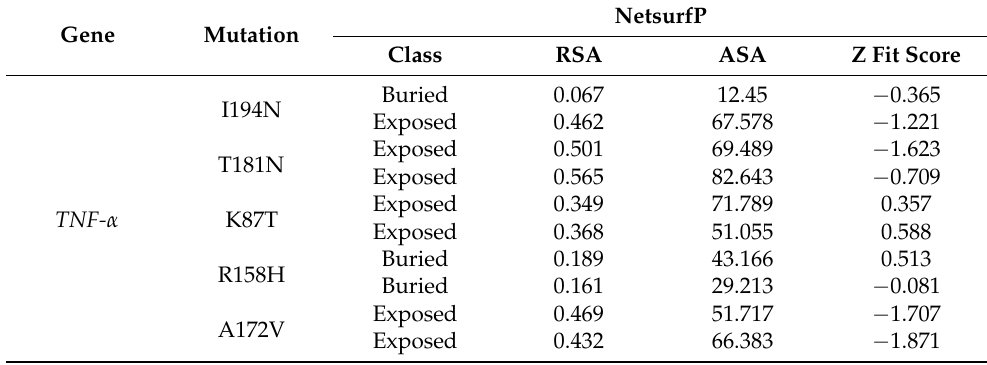
Table 5. Prediction of relative surface accessibility of TNF- α through NetsurfP.